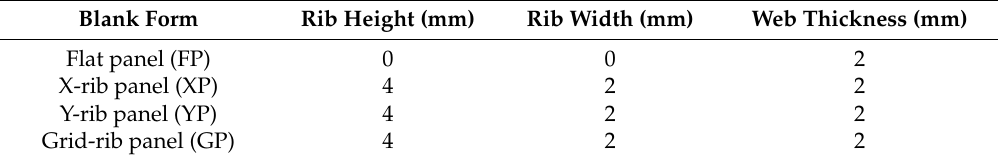
Table 1. Sizes of the panels samples.